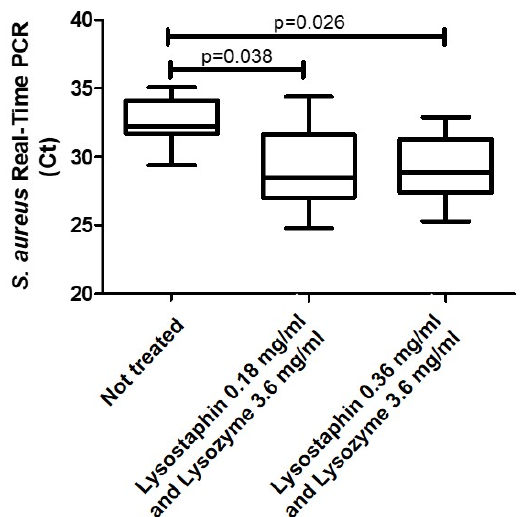
Figure 2. Comparison of median levels of real-time PCR for S. aureus across samples treated with lysostaphin at either 0.18 or 0.36 mg/mL and lysozyme (3.6 mg/mL) or without lytic enzymes treatment. Results expressed in cycle threshold ( C t). Kruskal–Wallis test: p = 0.041 (Experiment 2).